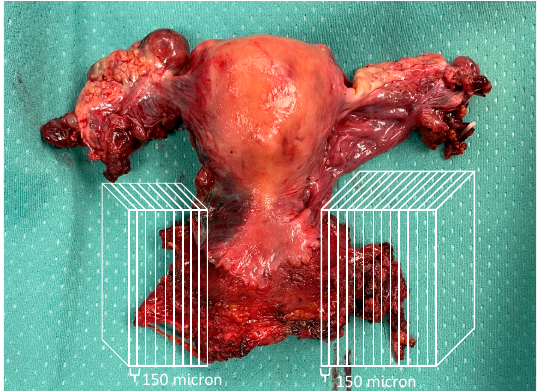
Figure 1. Example of how parametrial ultrastaging was performed (three-dimensional paraffin- embedded blocks were sliced at a distance of 150 microns).